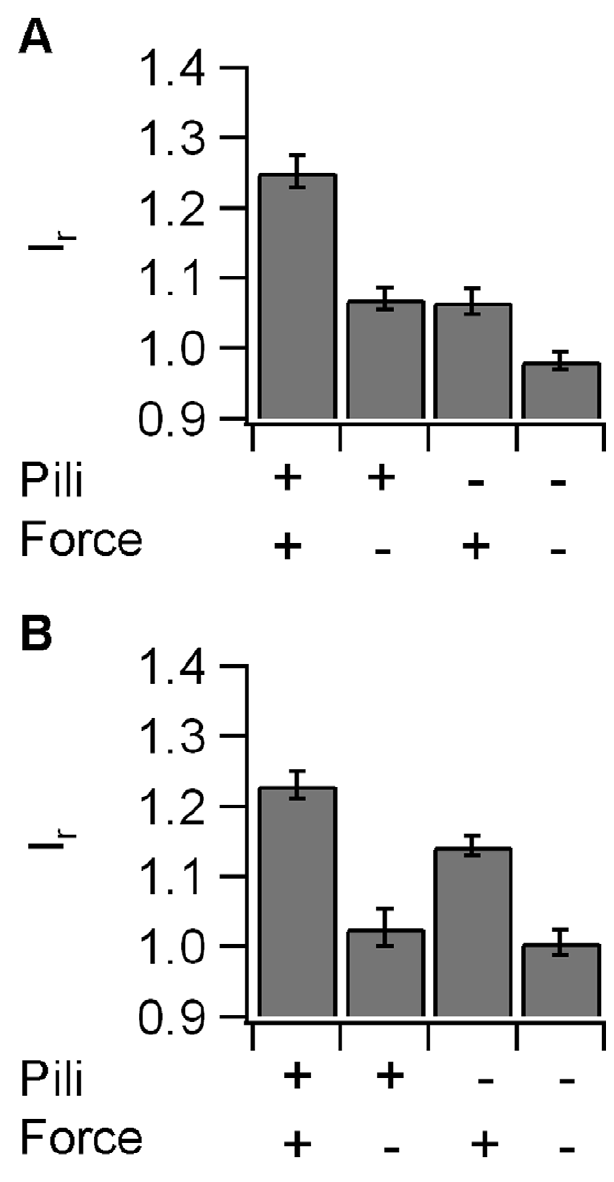
Figure 6. Accumulation of actin and ezrin after 20 min of force application. Average relative fluorescence intensity I r after 20 min of force application for A) actin-EGFP and B) ezrin-EGFP.